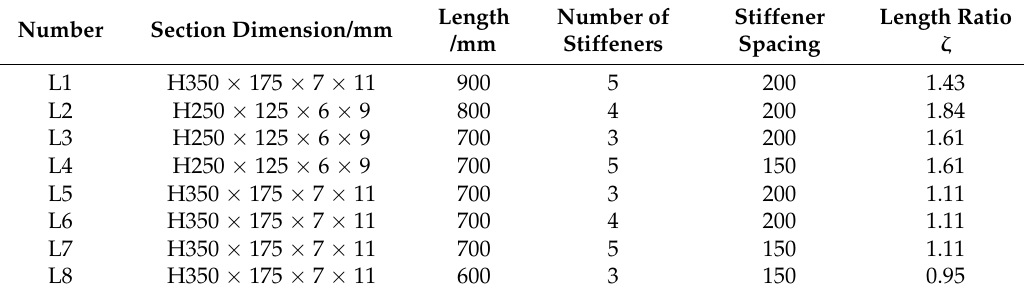
Welding access hole